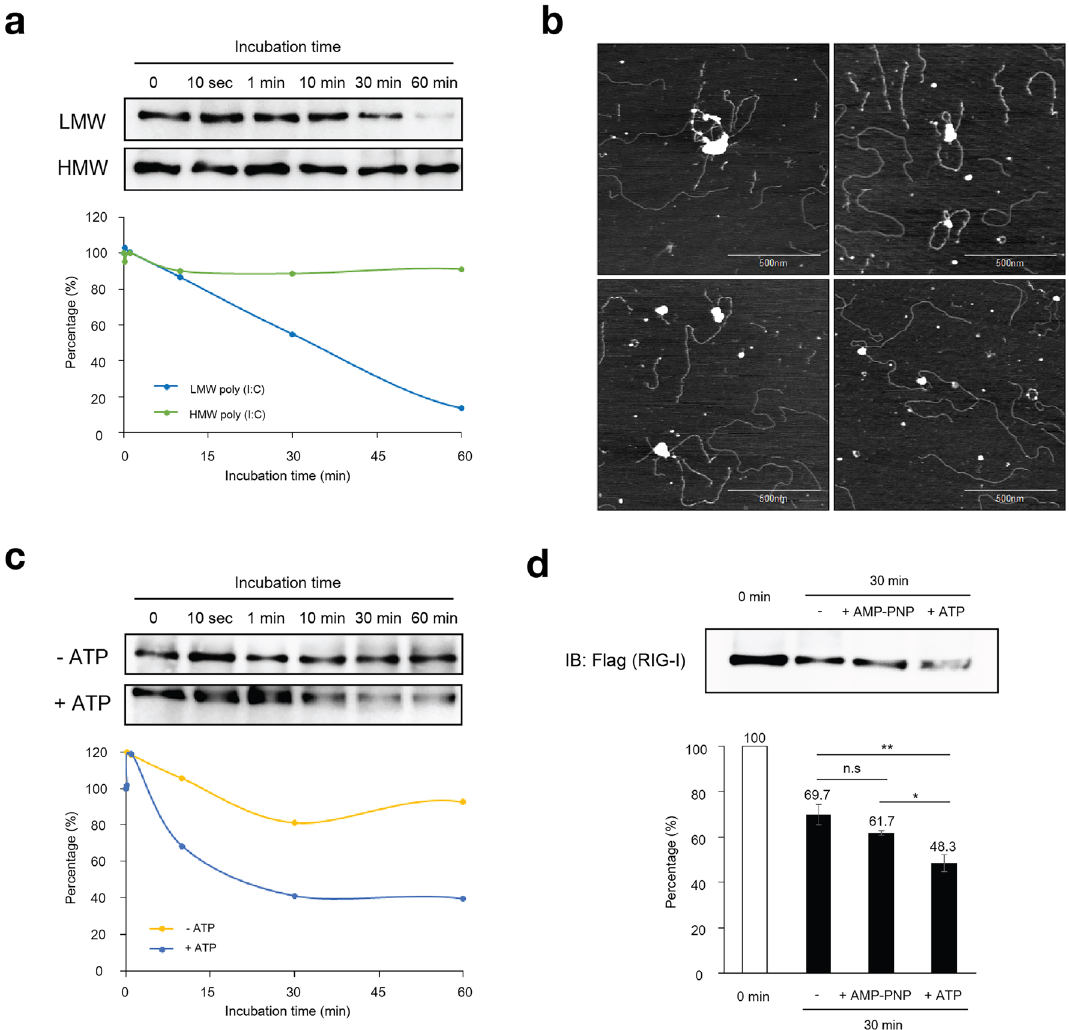
Figure 2. Dissociation of RIG-I/poly (I:C) complex in the presence of ATP. ( a ) Recombinant RIG-I (insect cells) was incubated with LMW or HMW poly (I:C) at 37 °C for 60 min as in Fig. 1C. RIG-I/poly (I:C) complexes on magnetic beads were collected. After washing the beads three times, ATP was added to the beads at final concentration of 1 mM and incubated at 37 °C for different times. RIG-I/dsRNA complexes remaining on the beads were isolated and analyzed by immunoblotting using anti-Flag (top). The dissociation kinetics was determining by quantification of the band intensities (bottom). The uncropped original blots are shown in Supplementary Fig. S8a. ( b ) AFM observation of RIG-I/HMW poly (I:C) complex. RIG-I and HMW poly (I:C) were incubated at 37 °C for 30 min, then further incubated in the presence of 1 mM ATP and subjected to AFM analysis. Four representative fields are shown. For size comparison, see AFM image of naïve RIG-I in Fig. 3A. ( c ) The effect of ATP on the dissociation of RIG-I/LMW poly (I:C) complex was analyzed. The RIG-I/LMW poly (I:C) complexes formed on the magnetic beads were isolated and incubated in the absence or presence of 1 mM ATP at 37 °C for different times. RIG-I bound to poly (I:C) (beads) was analyzed by immunoblotting as in (a). The uncropped original blots are shown in Supplementary Fig. S8b. ( d ) The effect of AMP-PNP on dissociation of RIG-I/LMW poly (I:C) complex. RIG-I/LMW poly (I:C) complex was incubated in the absence or presence of 1 mM AMP-PNP or ATP and analyzed as in (a). The uncropped original blot is shown in Supplementary Fig. S8c. The percentage of association and dissociation was calculated from band intensities (bottom). Error bars represent standard deviation (n = 3). * P < 0.05, . ** P < 0.01, unpaired Student’s t -test. n.s, not that CARD was masked in naïve RIG-I. Similarly, RIG-I complexed with LMW or HMW poly (I:C) showed very weak or no physical interaction with MAVS respectively since enough amounts of dissociated RIG-I cannot be produced in limited time. In contrast, dissociated RIG-I exhibited clear interaction with MAVS, suggesting that CARD was unmasked in dissociated RIG-I. These results strongly suggested that dissociated RIG-I is the signal- ing competent, active form.